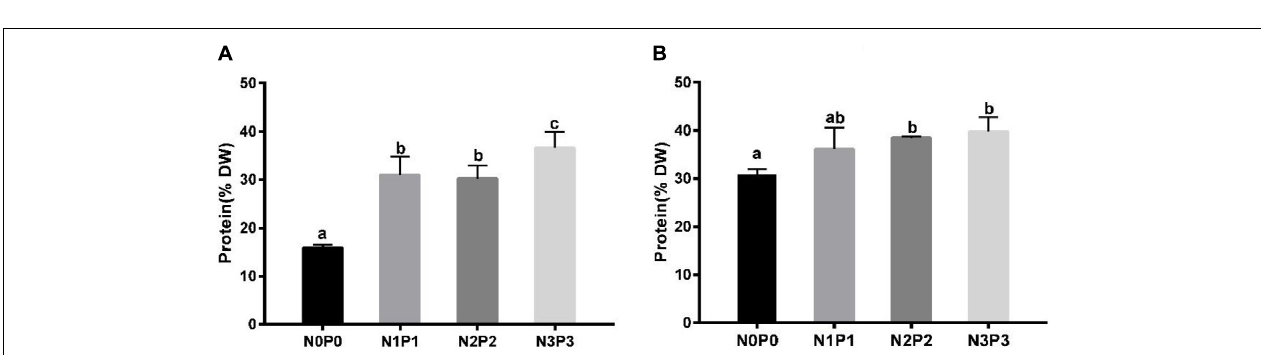
FIGURE 3 | Contents of phycoerythrin (PE), phycocyanin (PC) and allophycocyanin (APC) in thalli of Z-61 (A) and Z-26 (B) cultured under four different nutrient levels. From N0P0 to N3P3, the NO 3 − contents were 0.61, 1.81, 5.29, and 13.16 mg/L, while the PO 43 − contents were 0.09, 0.19, 0.65, and 1.34 mg/L, respectively. Values are means ± SD (n = 4). DW: dry weight.